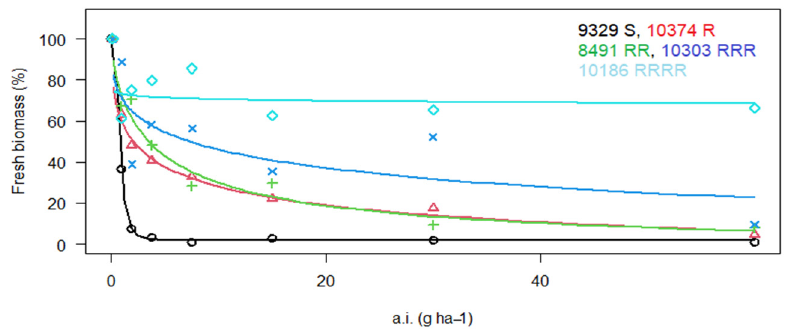
Figure 2. Dose-response curves of P. rhoeas populations resistant (R, RR, RRR, RRRR) and susceptible (S) to tribenuron-methyl.